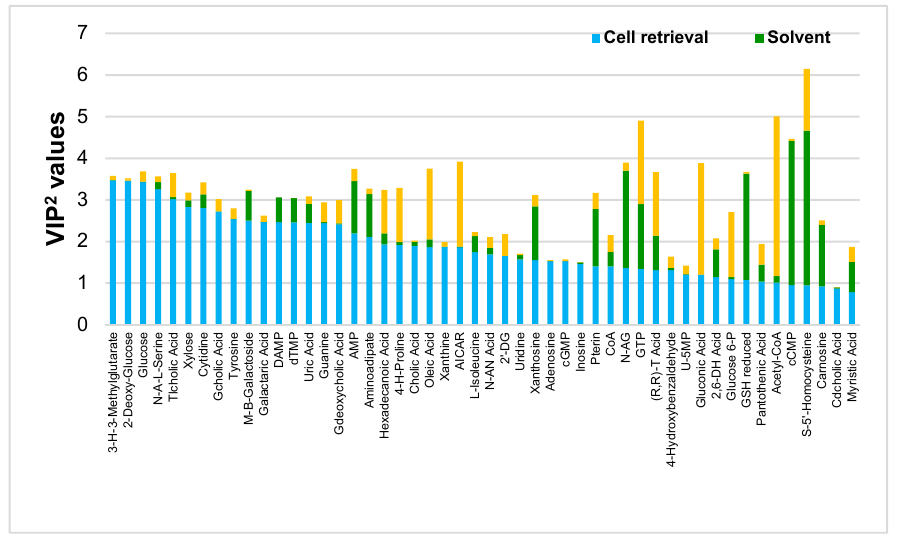
Figure 4. Effect-specific variable importance in the projection (VIP) 2 values for the 50 out of the 106 annotated metabolites ranked according to the impact of the cell retrieval effect.